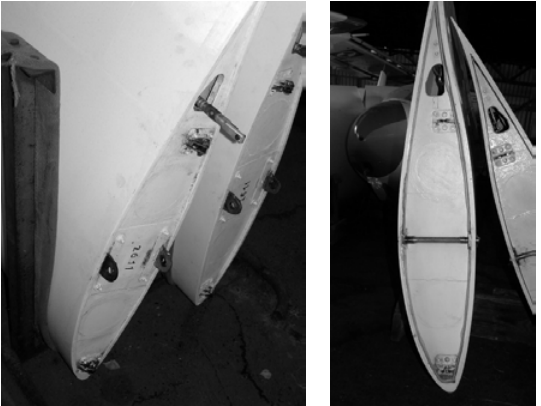
Fig 11. Joints between wing segments. Centre-wing left, wing tip right